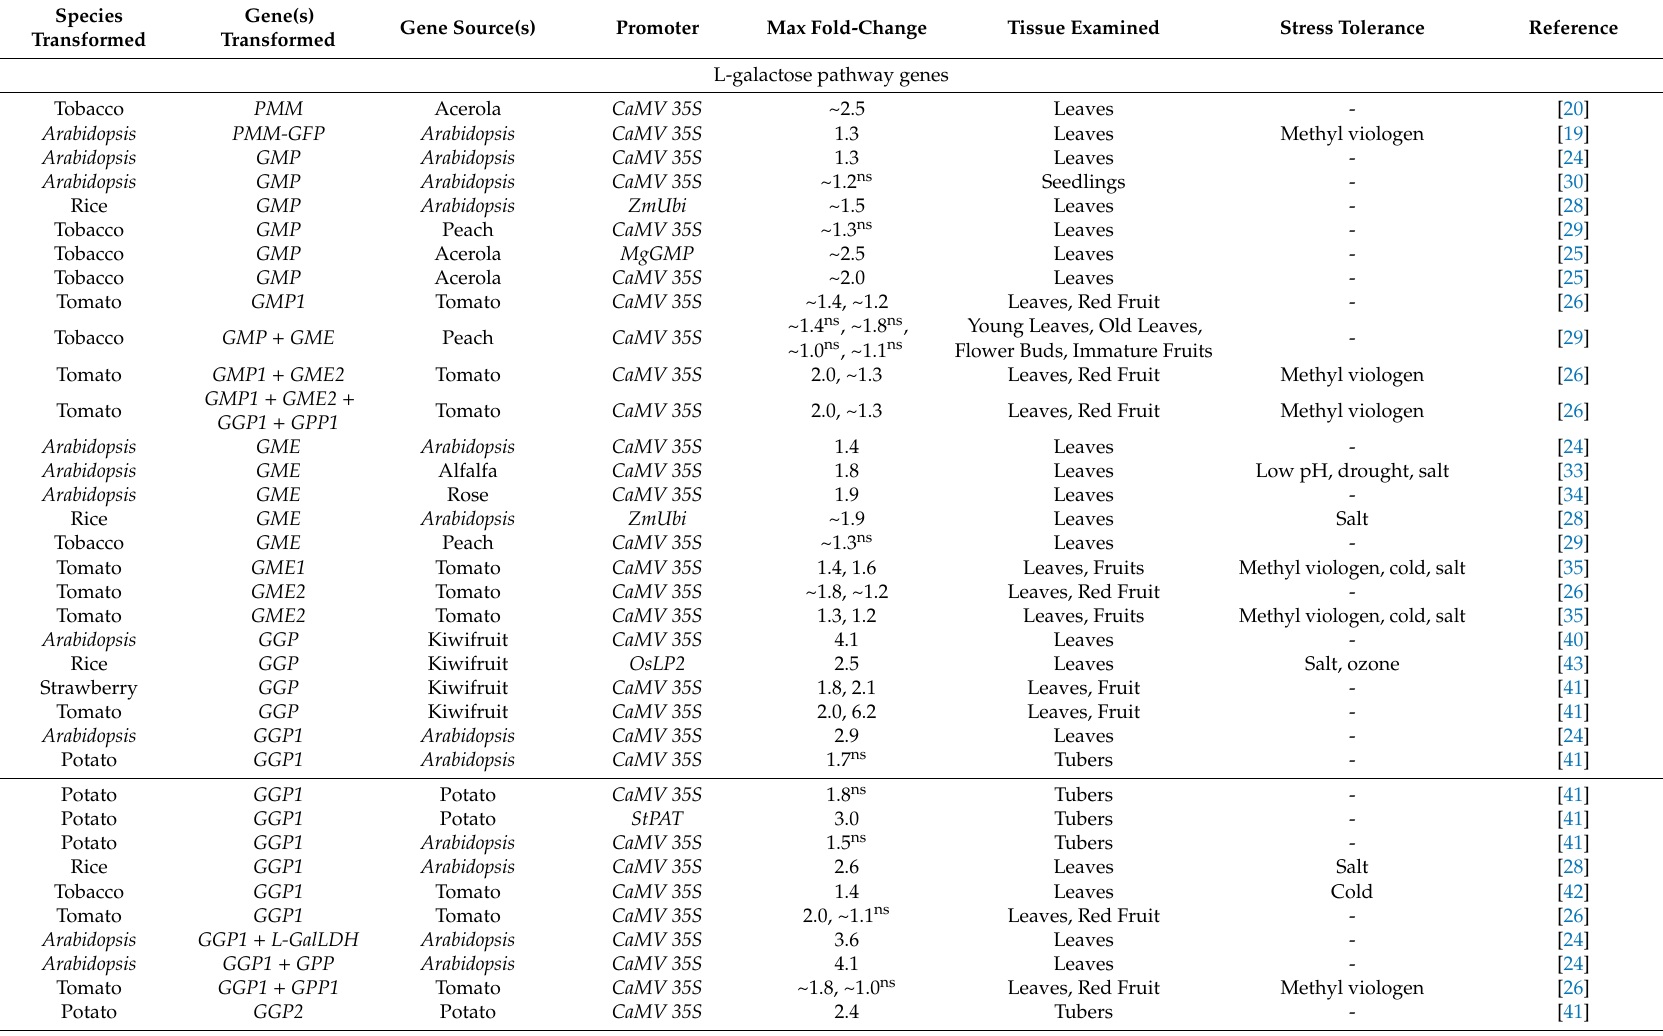
Table 1. Overview of metabolic engineering strategies utilizing ascorbate biosynthetic genes to increase ascorbate concentrations in model and crop species. Species Transformed